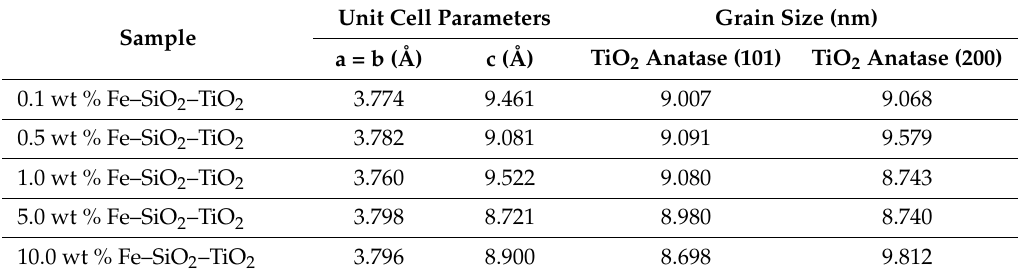
Table 4. Unit cell parameters and grain sizes of TiO 2 in STCF with differing Fe 3+ doping.